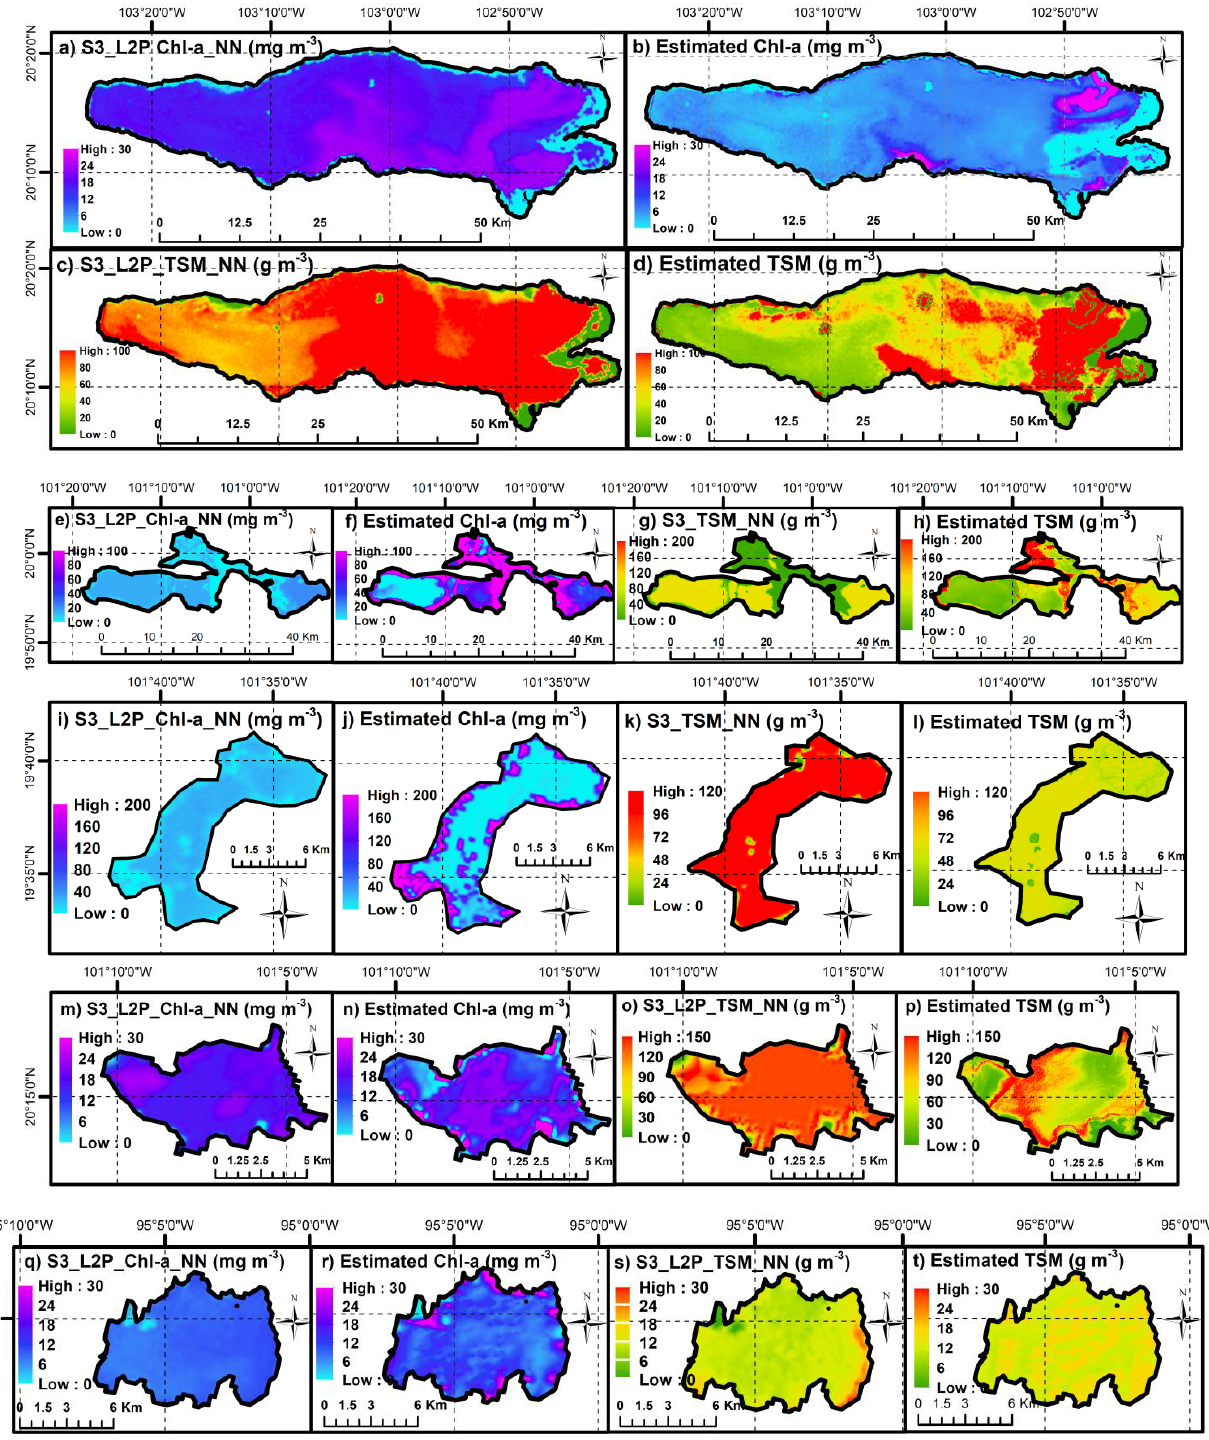
Figure 7 . Comparison of Chlorophyll-a (Chl-a) and total suspended matter (TSM) estimations by OLCI WFR products and developed the models in this study for all lakes.